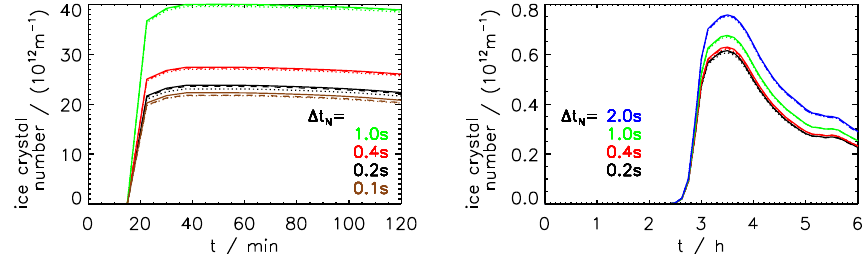
Fig. 8. Temporal evolution of total ice crystal number N for simulations with stochastic nucleation implementation. Analogous to Fig. 6, the left panel shows the short strong updraught event with w syn = 20cms − 1 and the right panel the weak longer-lasting updraught event with w syn = 2cms − 1 . The minimum number n min (in units m − 3 ) of ice crystals represented by a new SIP is 100 (dashed), 50 (solid) or 10 (dotted). The settings of the freezing time step are given in the legend. The black and red curves correspond to their counterparts in Fig. 6 where the original nucleation implementation was used.